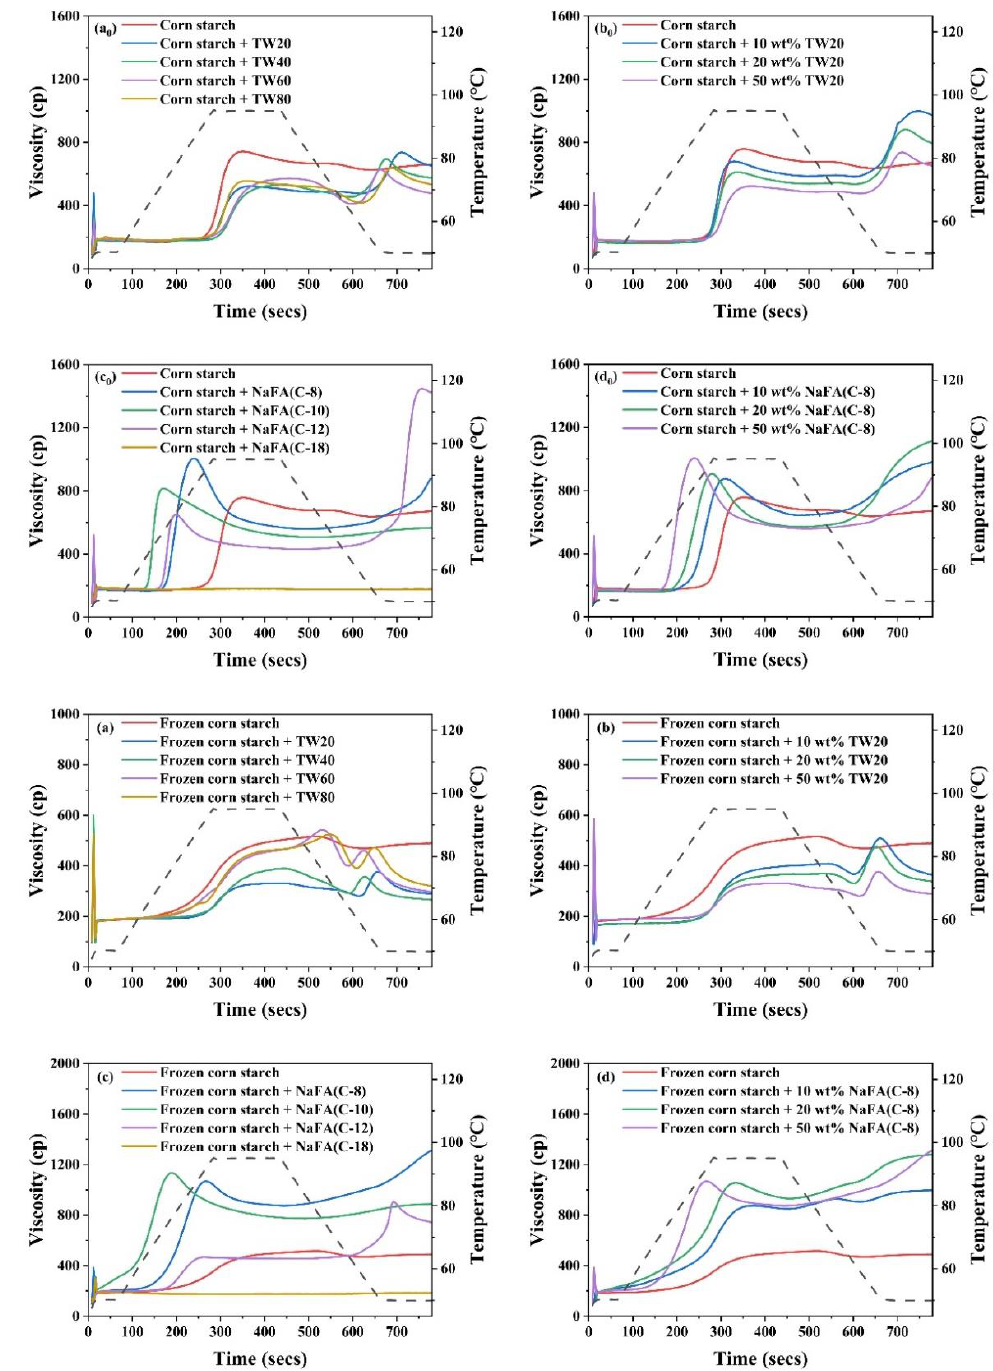
Figure 1. RVA pasting curves of regular ( a 0 – d 0 ) or frozen ( a – d ) corn starch in the presence of Tween (TW) and sodium fatty acid (NaFA). ( a 0 , a ) RVA curves in the presence of different types of TW (50 wt%). ( b 0 , b ) RVA curves in the presence of different concentrations of TW20. ( c 0 , c ) RVA curves in the presence of different types of NaFA (50 wt%) ( d 0 , d ) RVA curves in the presence of different concentrations of NaFA (C-8).